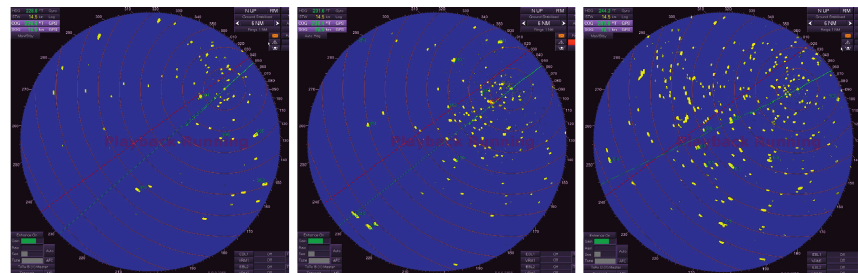
Figure 11: Radar echoes for three typical sea-ice navigation scenes.